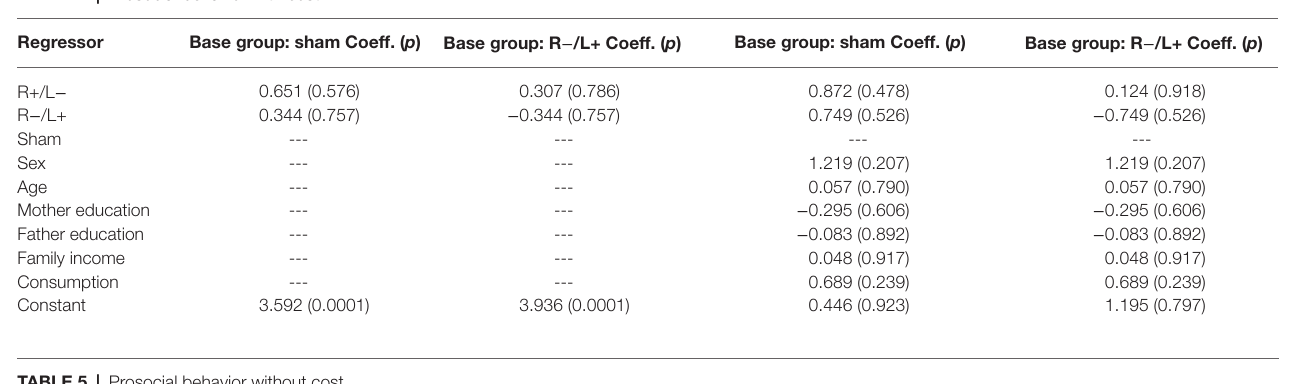
TABLE 5 | Prosocial behavior without cost. Regressor